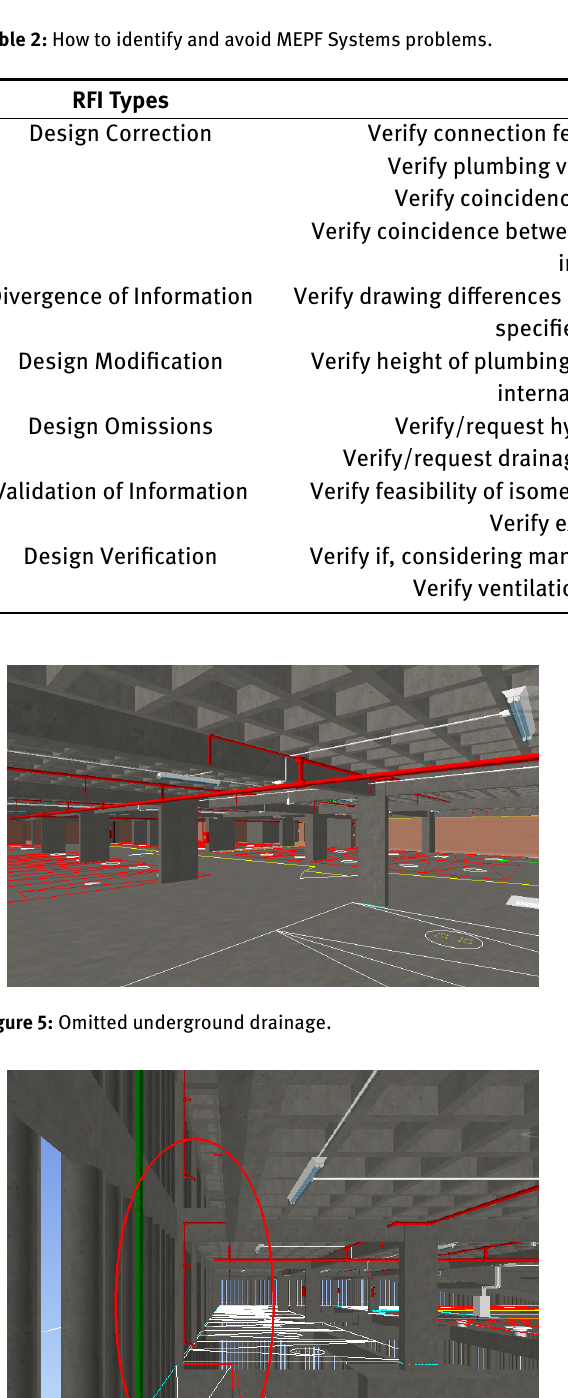
at enabling the use of the underground space and avoid inconvenience to the users.